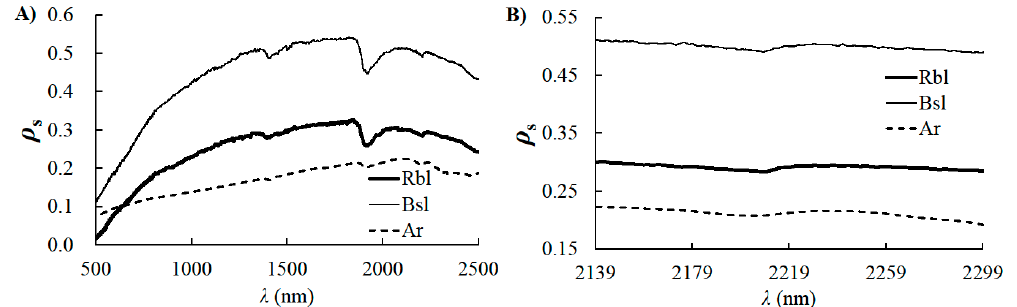
Figure 5. Surface albedo ( ρ s ) for ( A ) 500 to 2500 nm, ( B ) 2139 to 2299 nm, for three common scene elements: asphalt road (Ar), brown sandy loam (Bsl), and red-brown sandy loam (Rbl), respectively. Data key on figure. Spectra are from Environment for Visualizing Images (ENVI) library.